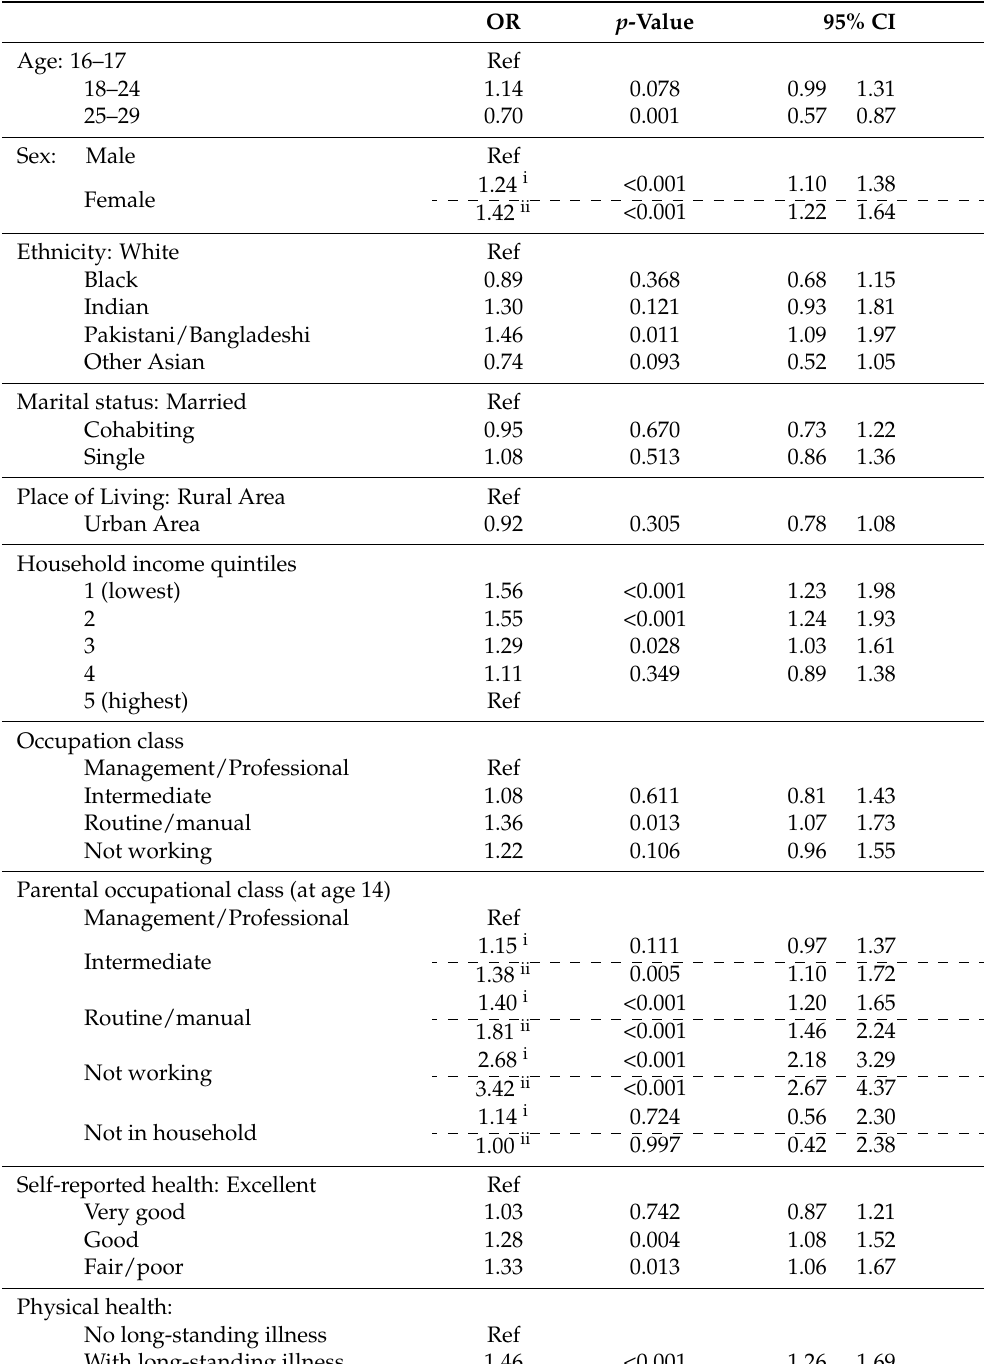
Table 2. Association between demographic, socioeconomic and health characteristics and duration of care (no care; cared once; cared for two or more waves). Odds Ratios and 95% CIs from covariate- adjusted generalised ordinal logistic model (with partial proportional